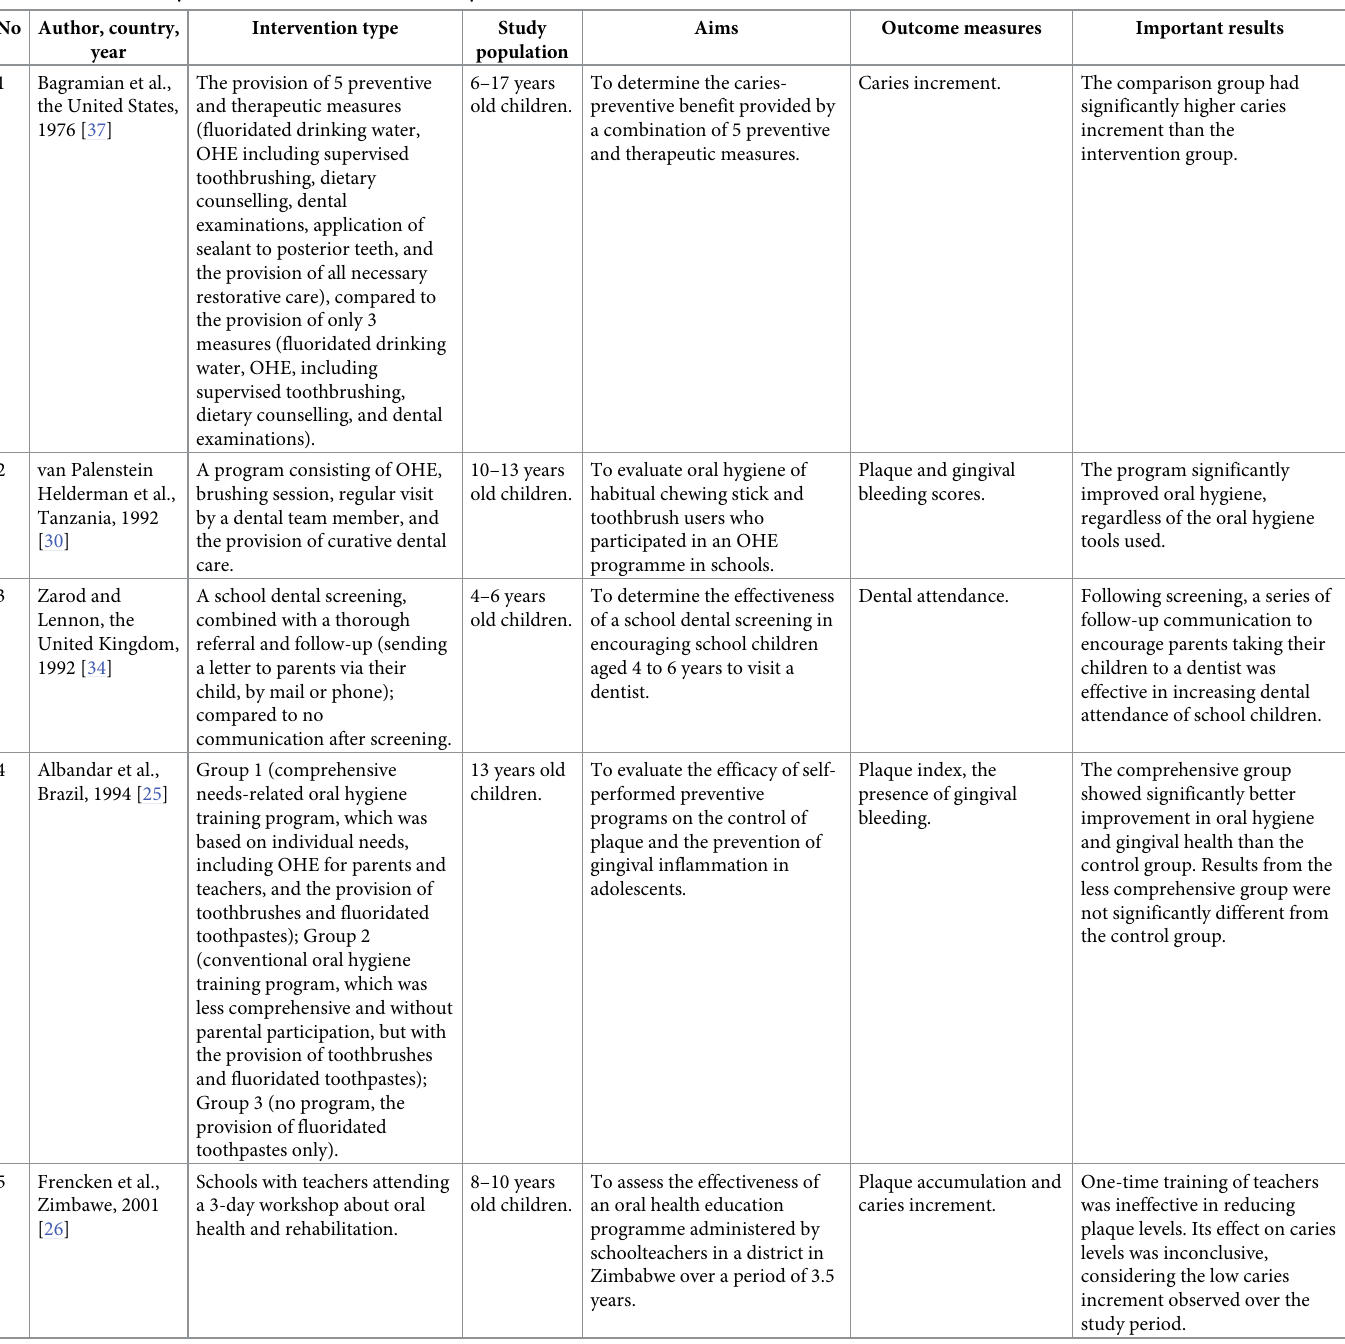
Table 2. The summary of studies conducted in elementary